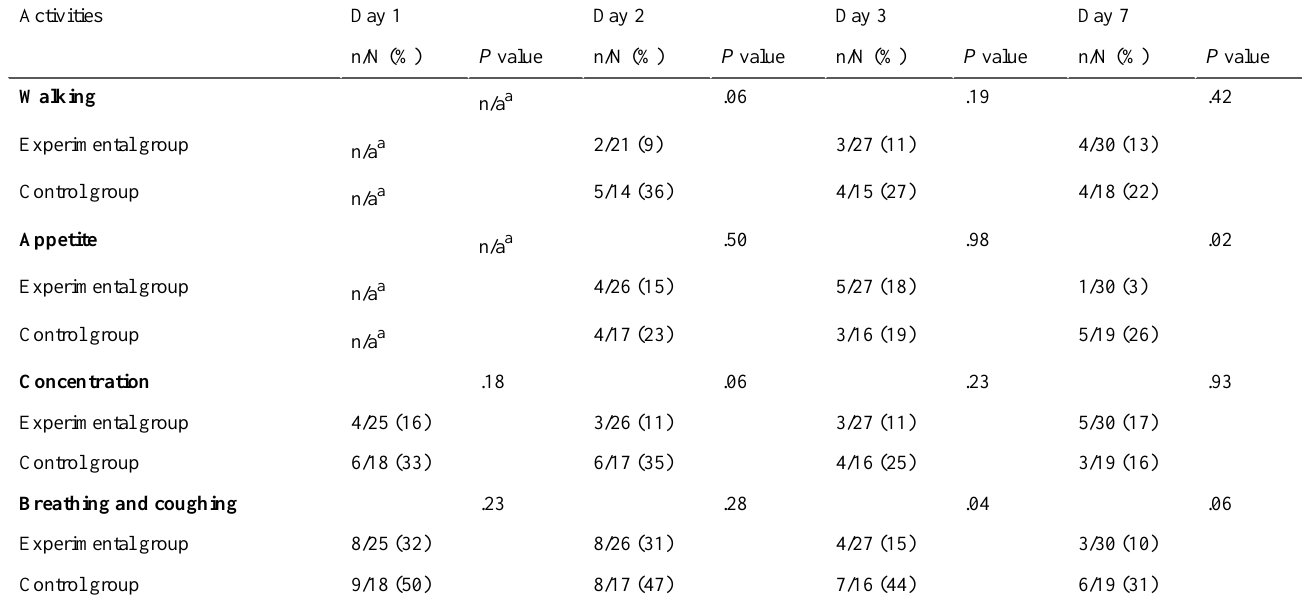
Table 4. Number and percentage of patients who reported severe pain interference ( ≥ 7/10) in specific activities as assessed by the Brief Pain Inventory (BPI) in the control and experimental